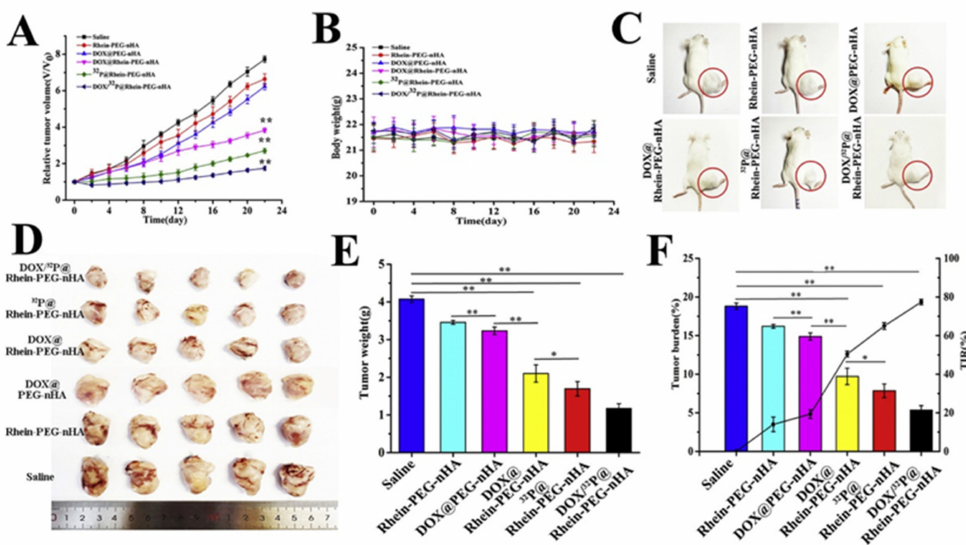
Figure 11. Xenograft tumors collected from mice that shows the reduction of tumoral mass after injection of Rhein-PEG-nano HAp (Rhein-PEG-nHAp): Rhein-PEG-nHAp NPs were synthesized and conjugated with DOX (DOX@Rhein-PEG-nHA), 32 P ( 32 P@Rhein-PEG-nHAp), or both DOX and 32 P ( 32 P/DOX@Rhein-PEG-nHA) for cancer treatment. For in vivo studies, Balb/c mice were injected with the NPs to compare the antitumoral effects. Saline, Rhein-PEG-HAp and DOX@nHA-PEG